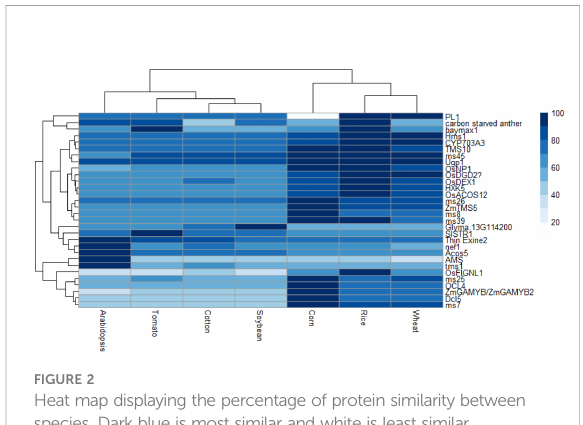
FIGURE 2 Heat map displaying the percentage of protein similarity between species. Dark blue is most similar and white is least similar.